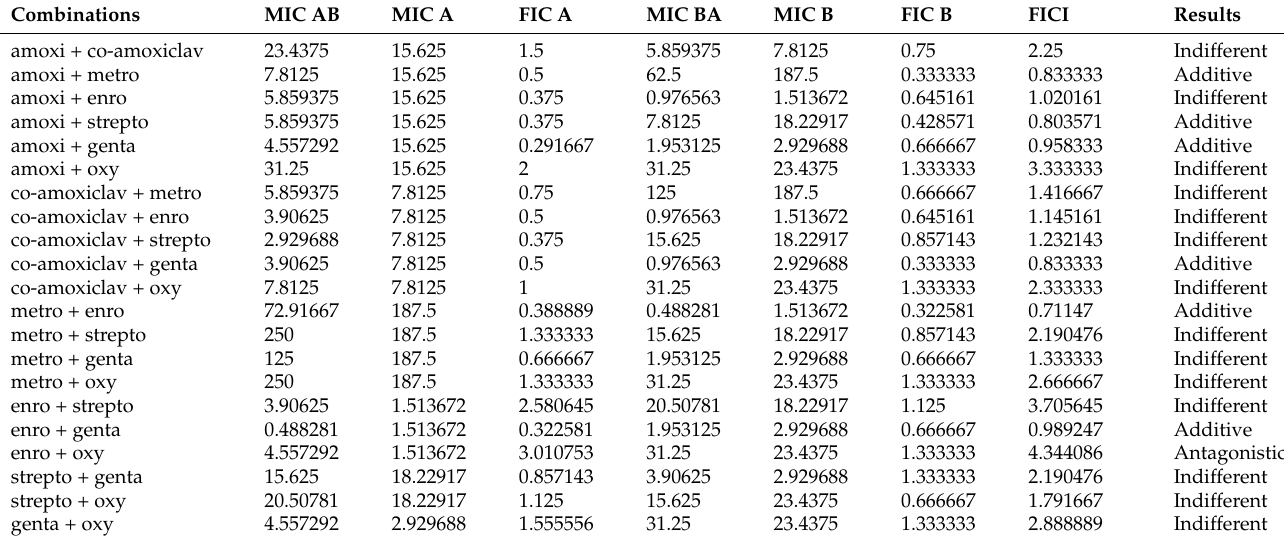
Table 5. Synergy testing of drugs against E. coli isolates.